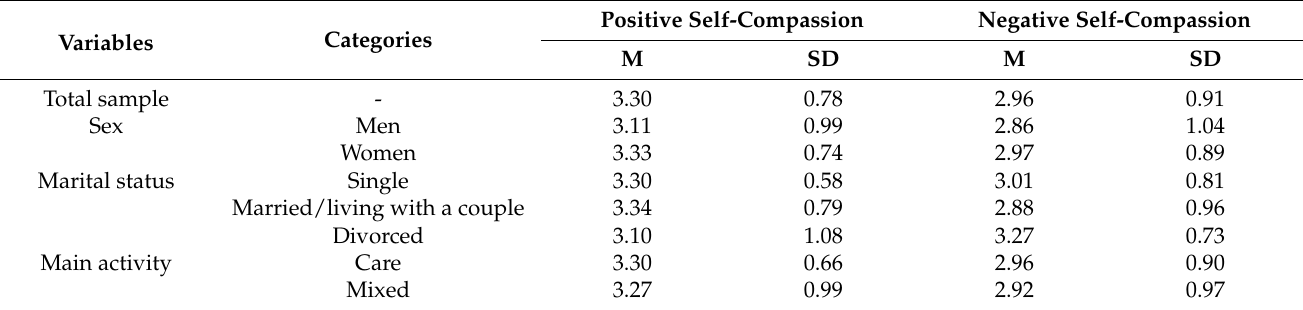
Table 4. Descriptive statistics for self-compassion in the different subgroups.